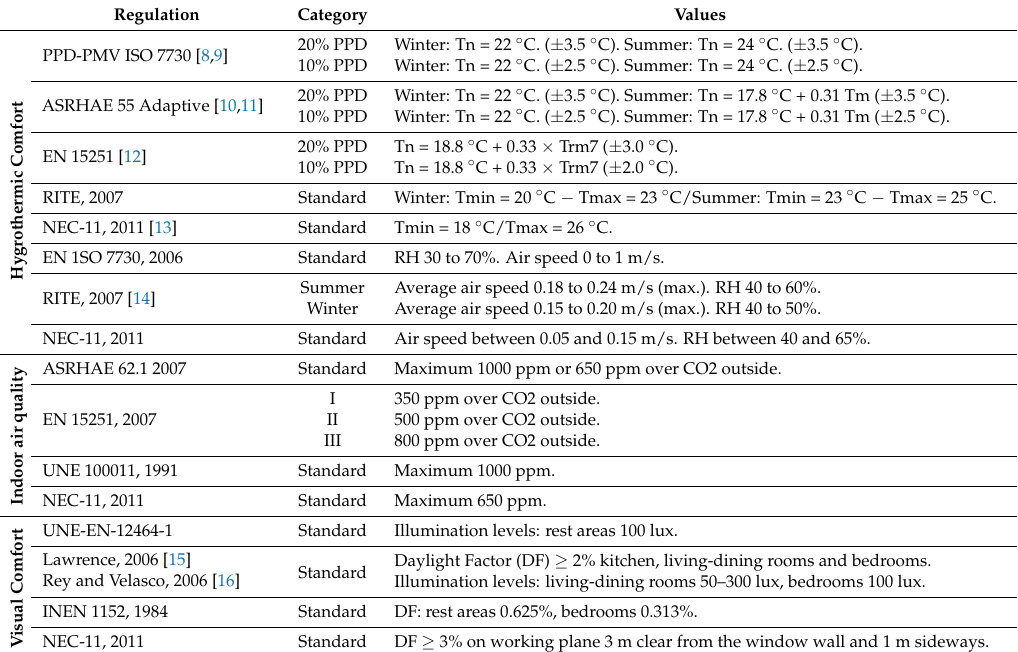
Table 1. Summary of established standards according to international and local